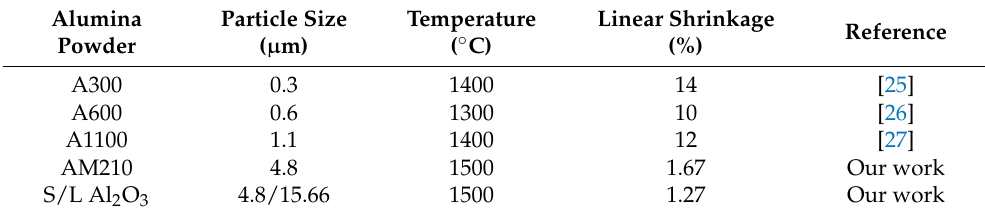
Figure 1. ( a ) Effect of large alumina particle (L-Al 2 O 3 ) concentration on the linear shrinkage of extruded support layer. ( b ) Typical SEM image of extruded alumina support layer composed of a mixture of S-Al 2 O 3 and L-Al 2 O 3 particles (70:30). ( c ) Typical SEM image of extruded alumina support layer composed of S-Al 2 O 3 particles. Table 2. Linear shrinkage rate of reported alumina support